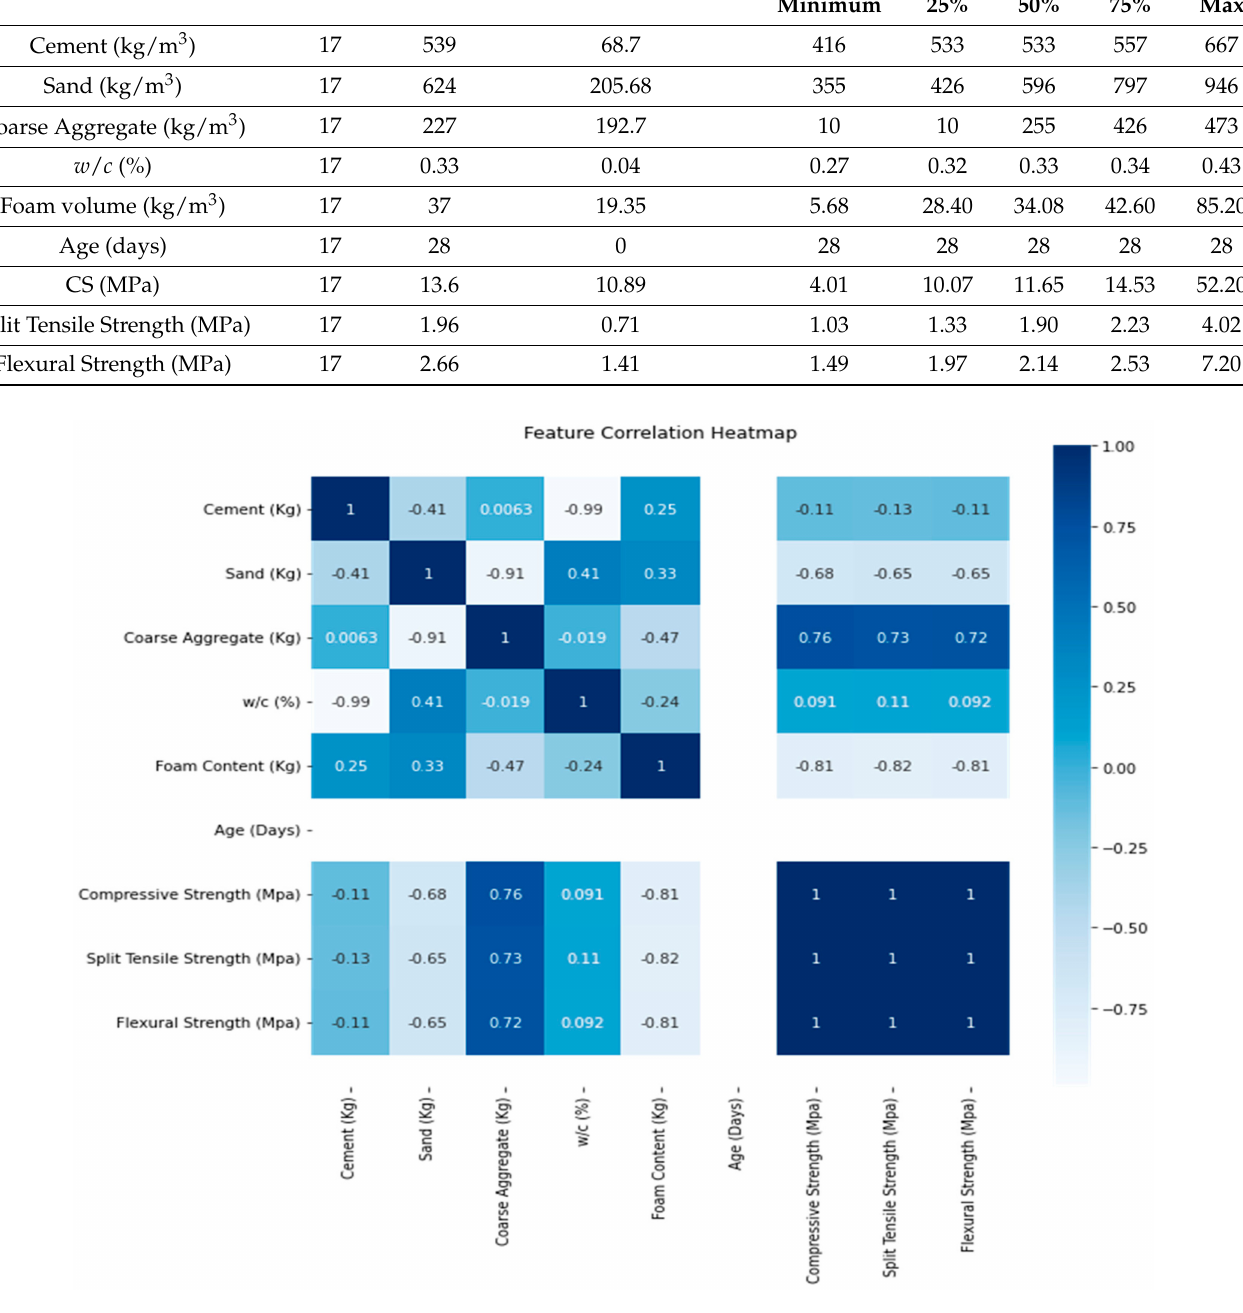
Figure 8. Correlation of Parameters in